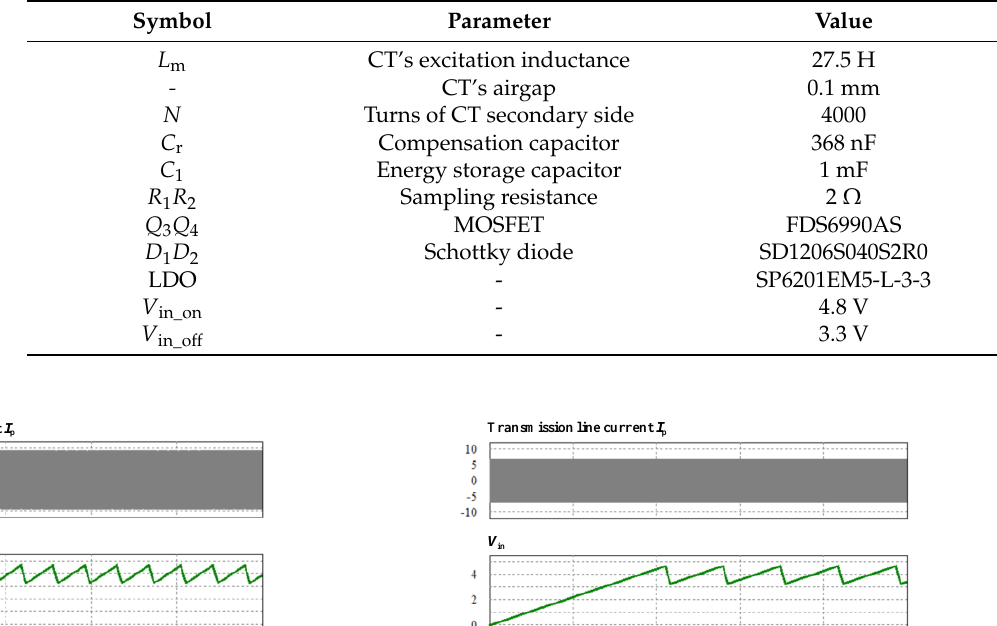
Table 1. Parameters of the prototype.